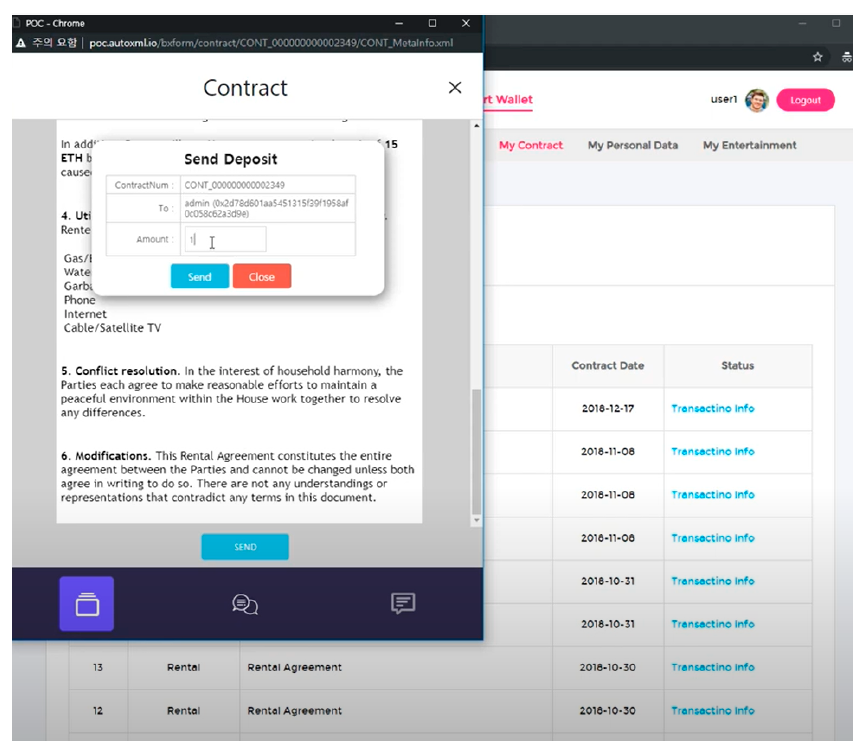
Figure 16. Blockchain deposit screen for real estate transaction.